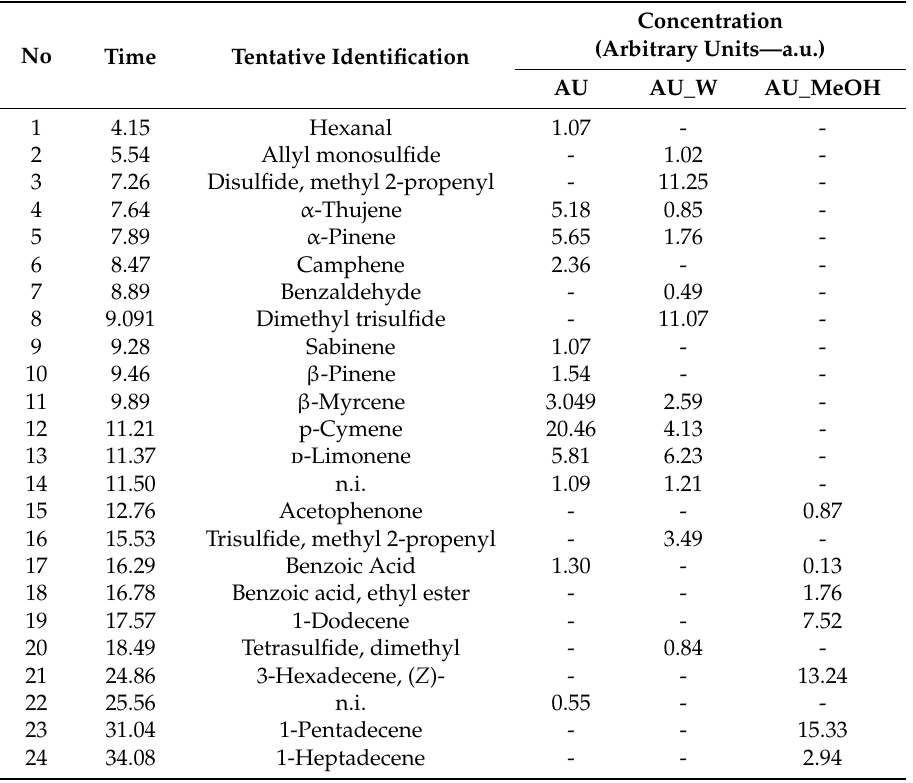
Table 5. Tentative identification of major compounds identified in Allium ursinum comparative with Allium ursinum water and methanolic extracts. Concentration (Arbitrary Units—a.u.) Tentative Identification